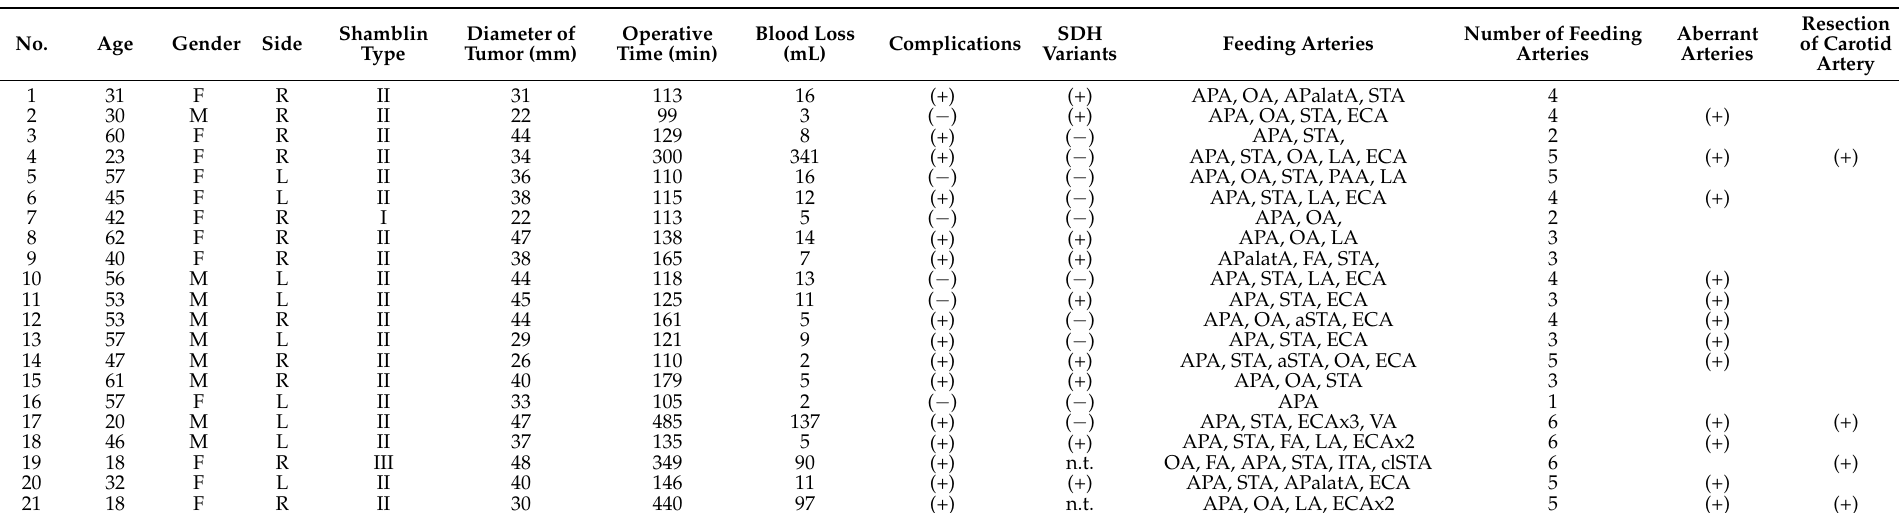
Table 1. Patient